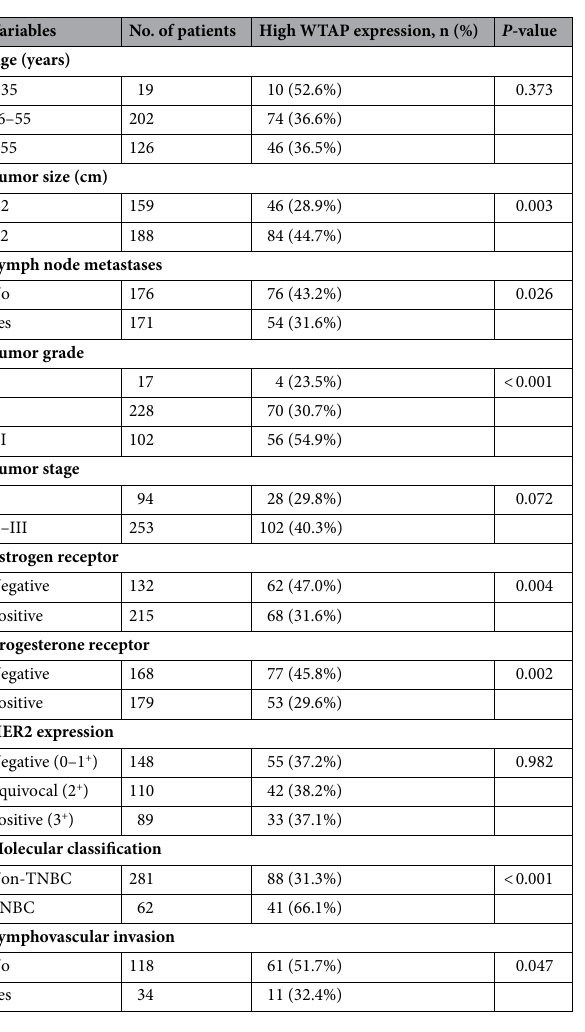
Table 2. Association of WTAP expression with clinicopathological parameters in breast cancer patients. *High WTAP expression was defined as a nuclear staining intensity of positive cancer cells of 3 13 . HER2 human epidermal growth factor receptor 2, TNBC triple-negative breast